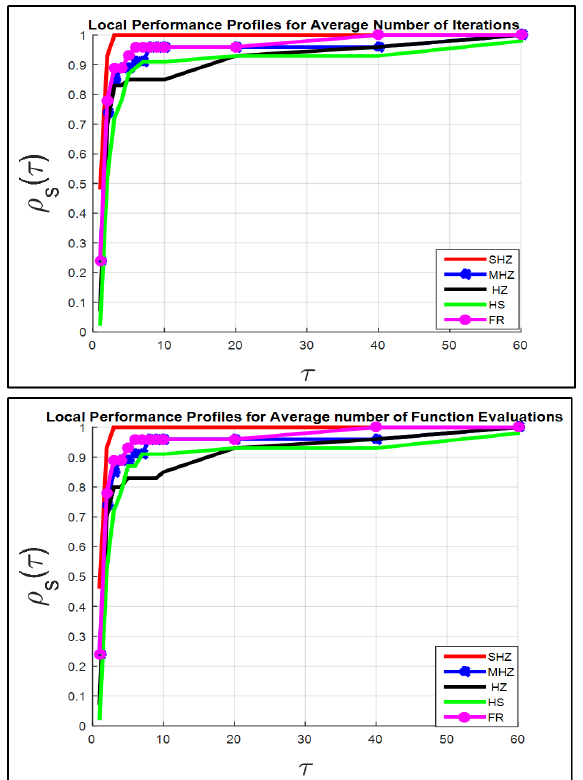
Figure 4. Plotting the results of the terms itr.a and FEs.a for 5